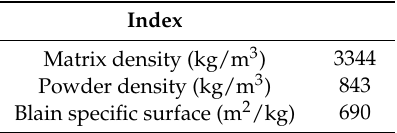
Table 2. Physical properties of used MgO powder.